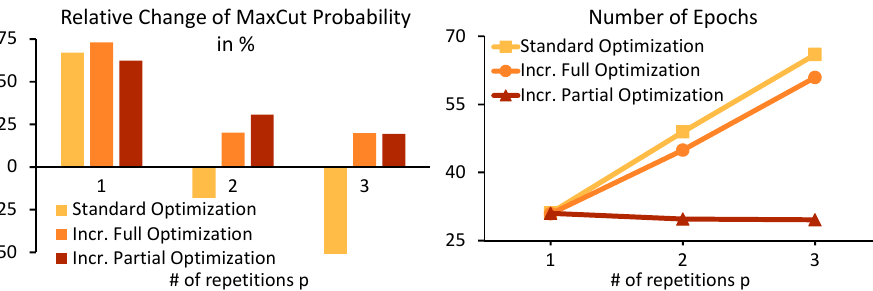
Figure 7. ( Left ): Mean relative change of the MaxCut probability observed in experiments analogous to Figure 6 optimized with F Greedy and ε = 0.15 for newly generated 12-node graphs as prescribed in Section 5.2. Only problem instances, for which a MaxCut probability significantly higher than what could be expected from uniform random sampling ( > 0.1%) was found, were considered (7 × G 12, 3r , 14 × G 12, rand , and 6 × G 12, fc ). ( Right ): Average number of epochs of the standard, incremental full, and incremental partial